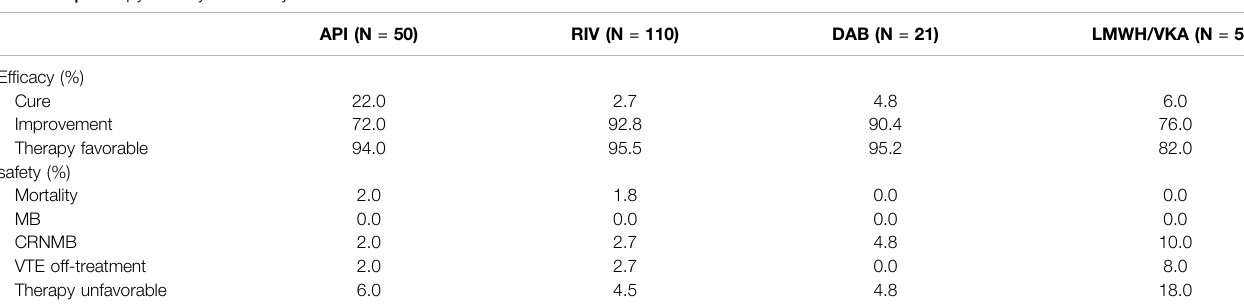
TABLE 4 | Therapy ef fi cacy and safety